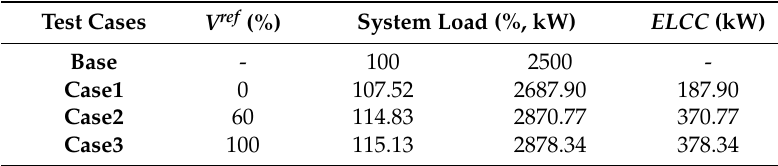
Table 4. Load carrying capability ( ELCC ) Evaluation